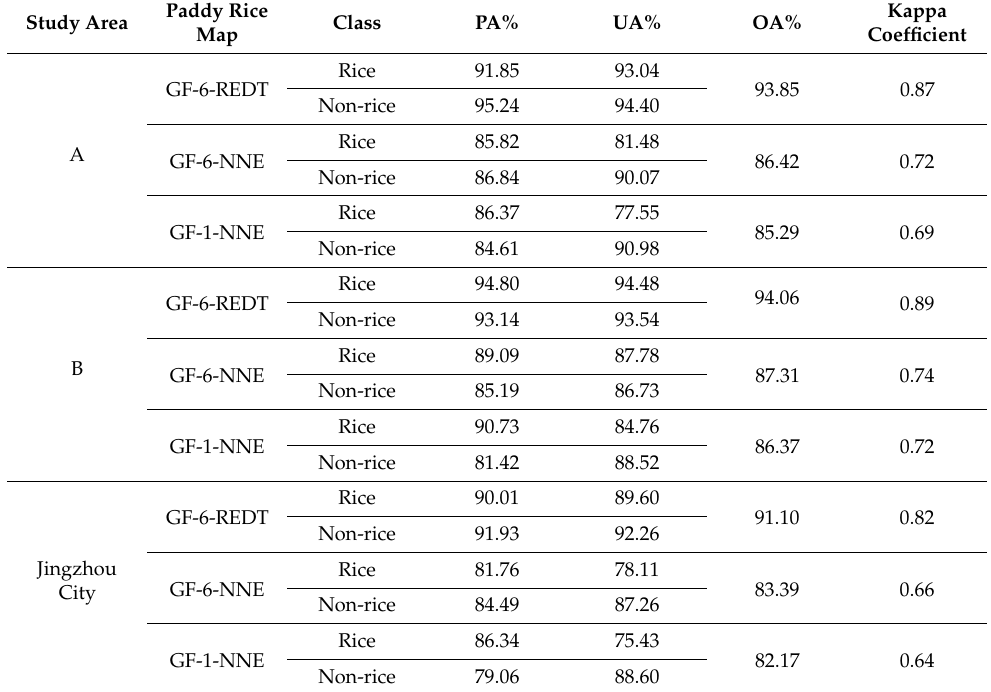
Figure 9. The comparison of three local paddy rice maps in A and B region (( a ) A-GF-6 image; ( b ) A-red-edge decision tree (REDT) method based on GF-6 rice map; ( c ) A-normalized difference vegetation index (NDVI), normalized difference water index (NDWI), enhanced vegetation index (NNE) method based on GF-6 rice map; ( d ) A-NNE method based on GF-1 rice map; ( e ) B-GF-6 image; ( f ) B-REDT method based on GF-6 rice map; ( g ) B-NNE method based on GF-6 rice map; ( h ) B-NNE method based on GF-1 rice map). Table 3. Confusion matrix of local (A and B) and Jingzhou city accuracy assessment using field measured data and Google Earth images (A:800 pixels rice samples,1300 pixels non-rice samples; B: 900 pixels rice samples, 700 pixels non-rice samples; Jingzhou city: 4000 pixels rice samples, 6000 pixels non-rice samples).